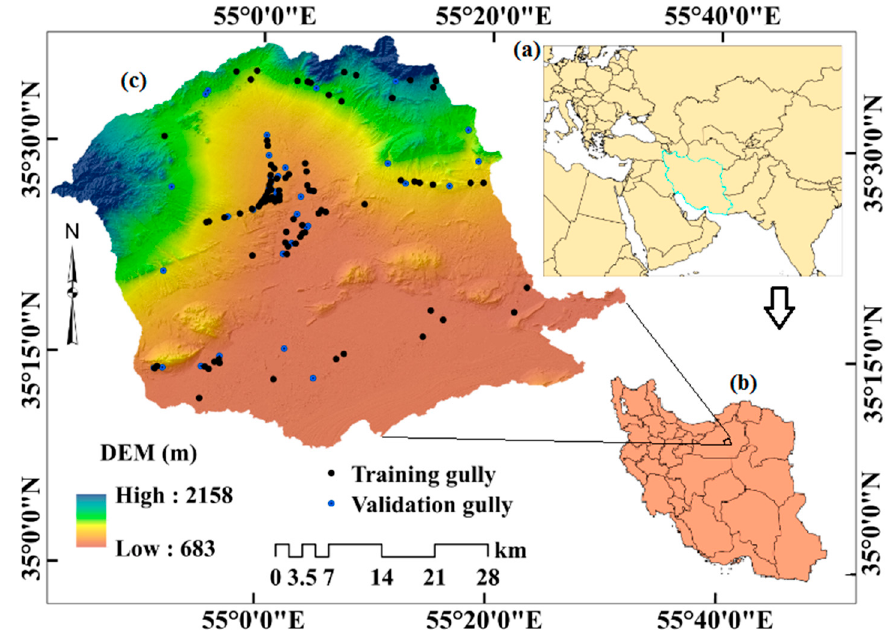
Figure 1. Study area. ( a ) Location of Iran in the world, ( b ) location of study area in Iran and ( c ) location of training and validation gullies in the study area.